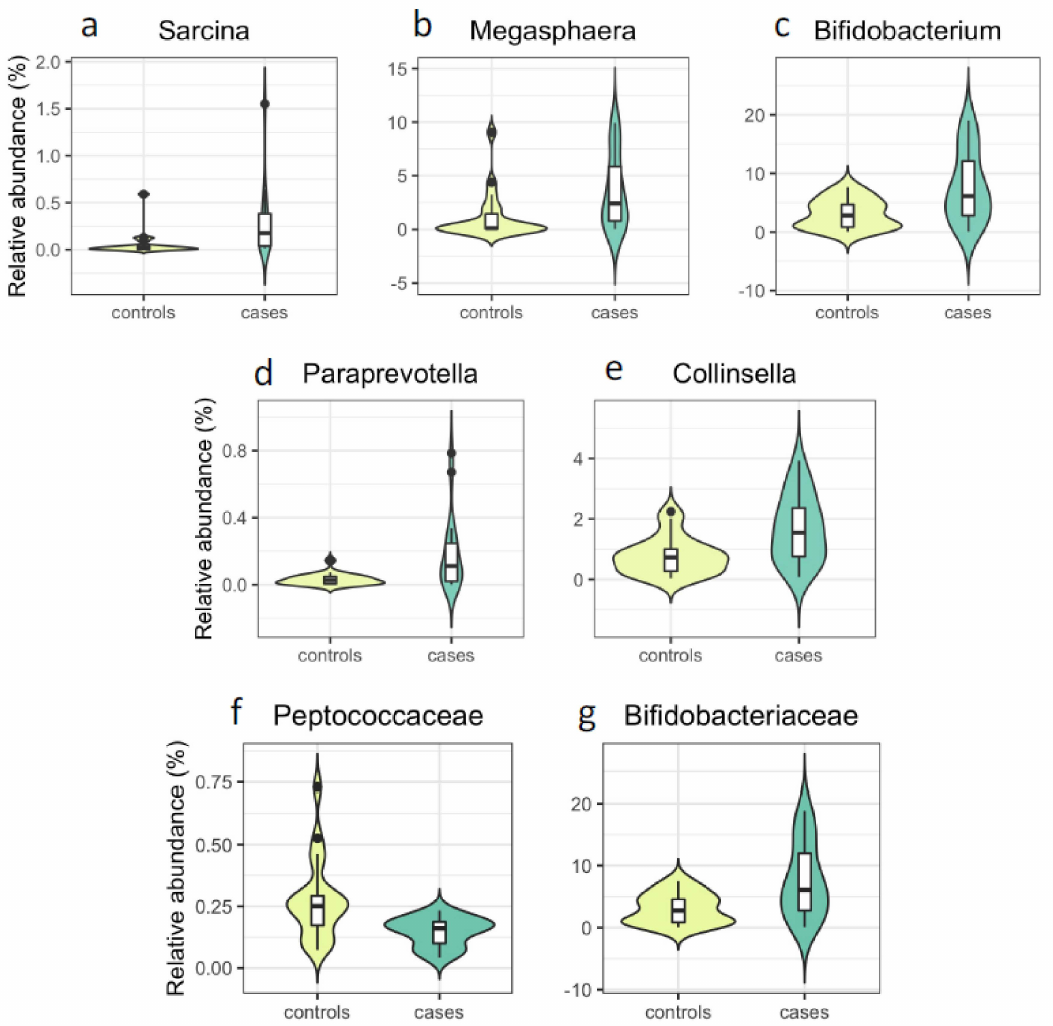
Figure 2. Violin plots showing the distributions of the bacterial genera ( a – e ) and families ( f , g ), reaching statistical significance consistently in all statistical models from Tables 2 and 3.